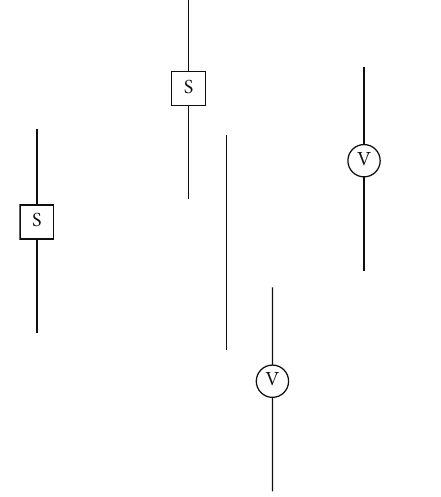
Figure 3: A 5-element CSPA.